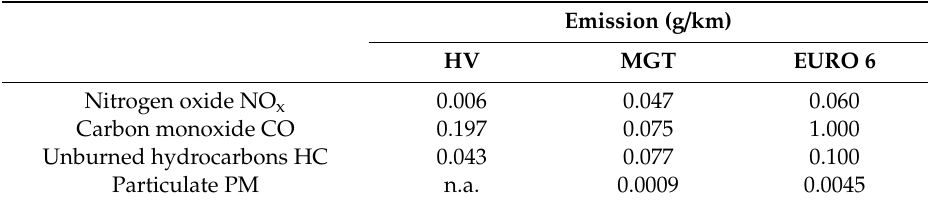
Table 32. Comparison of polluting